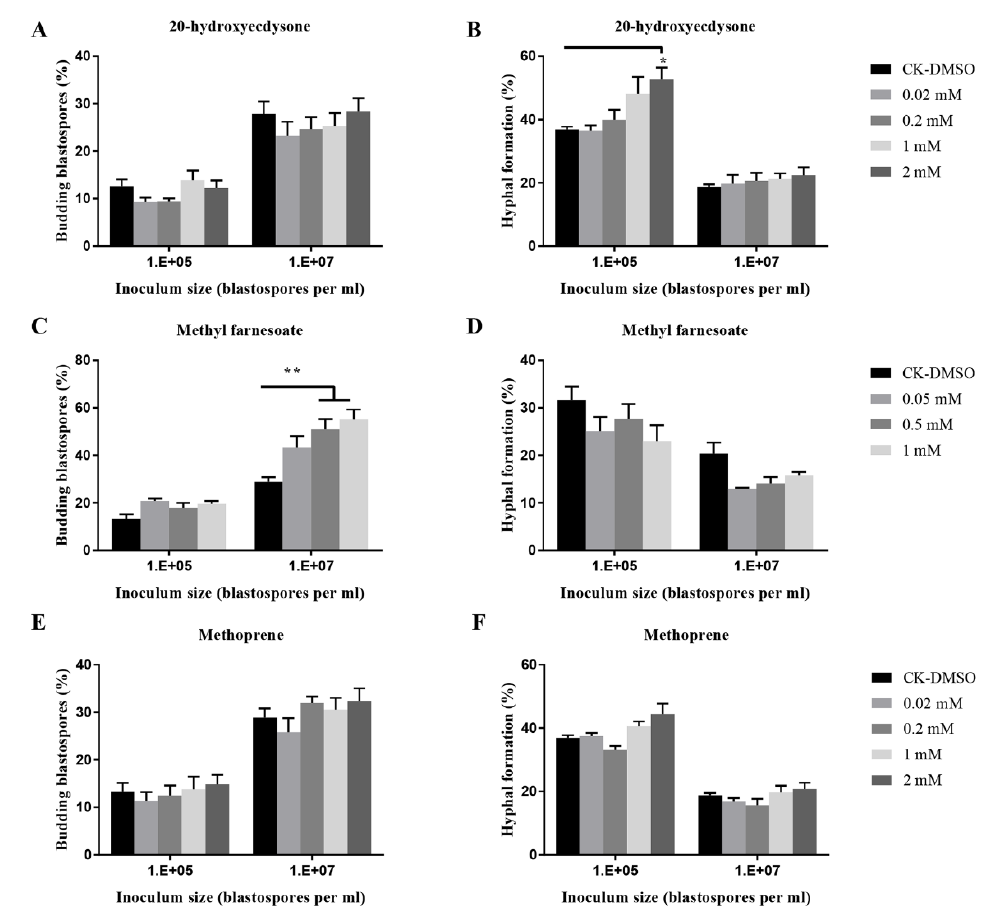
Figure 7. E ff ects of insect hormones and their analogs on budding growth ( A , C , E ) and hyphal formation Figure 7. Effects of insect hormones and their analogs on budding growth ( A,C,E ) and hyphal ( B , D , F ) of O. sinensis in liquid PM medium 8 days after inoculation. p < 0.05 (*) and p < 0.01 (**). formation ( B,D,F ) of O. sinensis in liquid PM medium 8 days after inoculation. p < 0.05 (*), p < 0.01 (**) and p < 0.001 (***). Table 1. E ff ect of L-proline and N -acetylglucosamine on biomass accumulation of O. sinensis